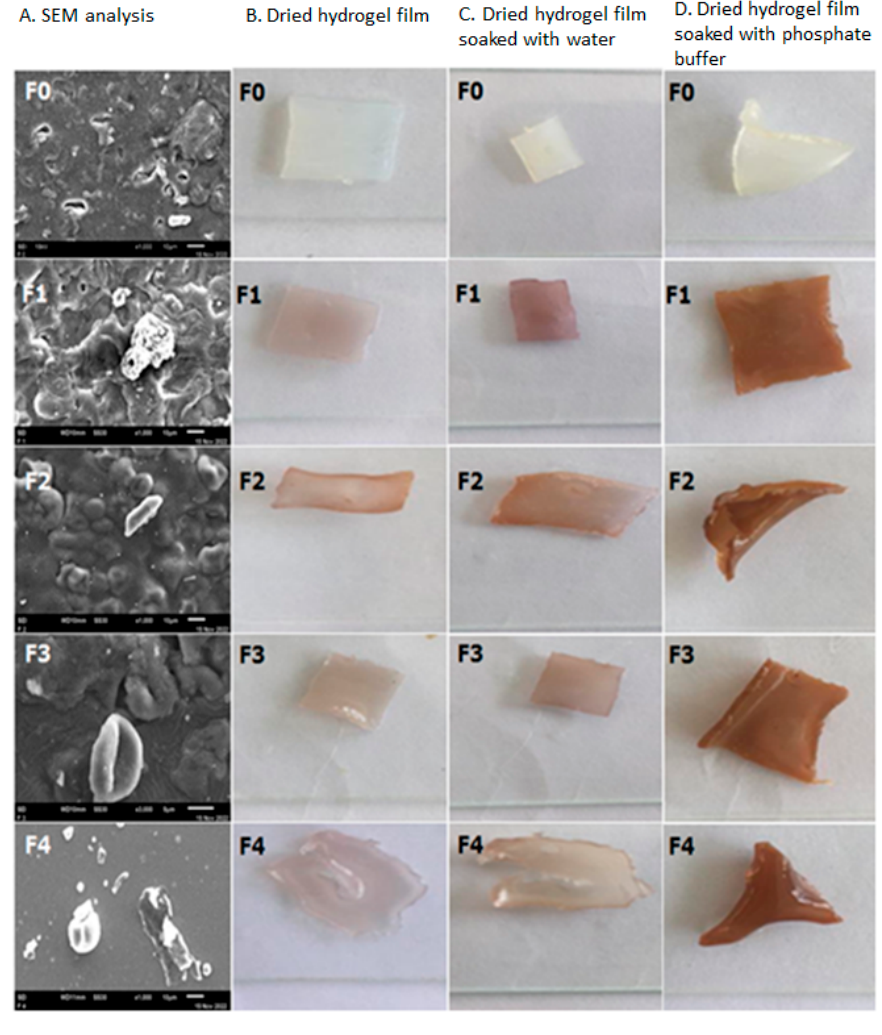
Figure 7. SEM analysis of Polyvinyl alcohol/Corn starch/Patchouli oil Hydrogel films ( A ) loaded with silver nanoparticles (F 0 ; F 1 ; F 2 ; F 3 ; and F 4 ); ( B ) Dried hydrogel; ( C ) Dried hydrogel soaked with water, and ( D ) Dried hydrogel soaked with phosphate buffer.